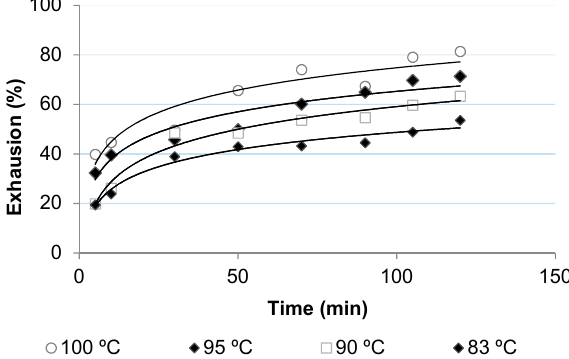
Figure 4. Dyeing kinetics for PES fabric dyed with Disperse Blue 79 and Coumarin.